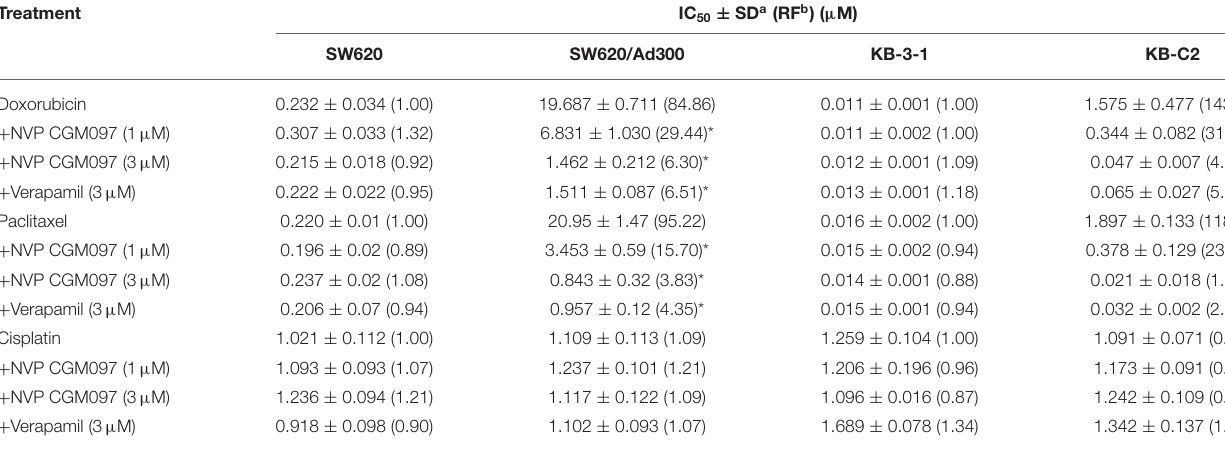
TABLE 1 | NVP-CGM097 sensitized ABCB1-substrate-selected resistant cells to ABCB1 substrates.